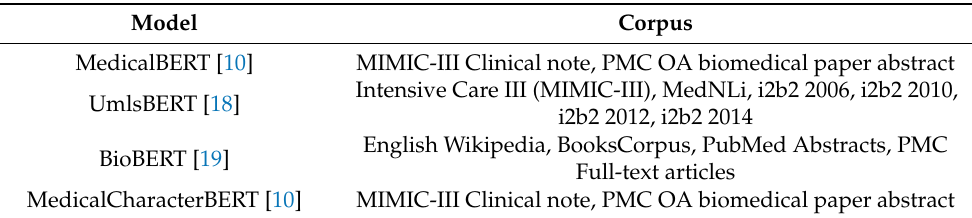
Table 2. The pre-training model and learned